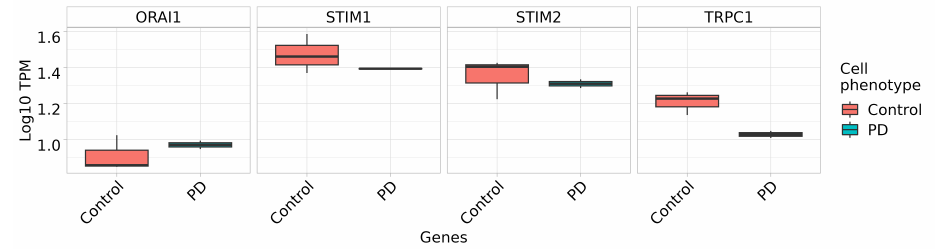
Figure 13. Expression of genes associated with the electrophysiological activity in setloc dataset. DAns differentiated from IPSFF1S represent “Control”, DAns differentiated from IPSPDL2.6S (muta- tion G2019S in LRRK2) represent